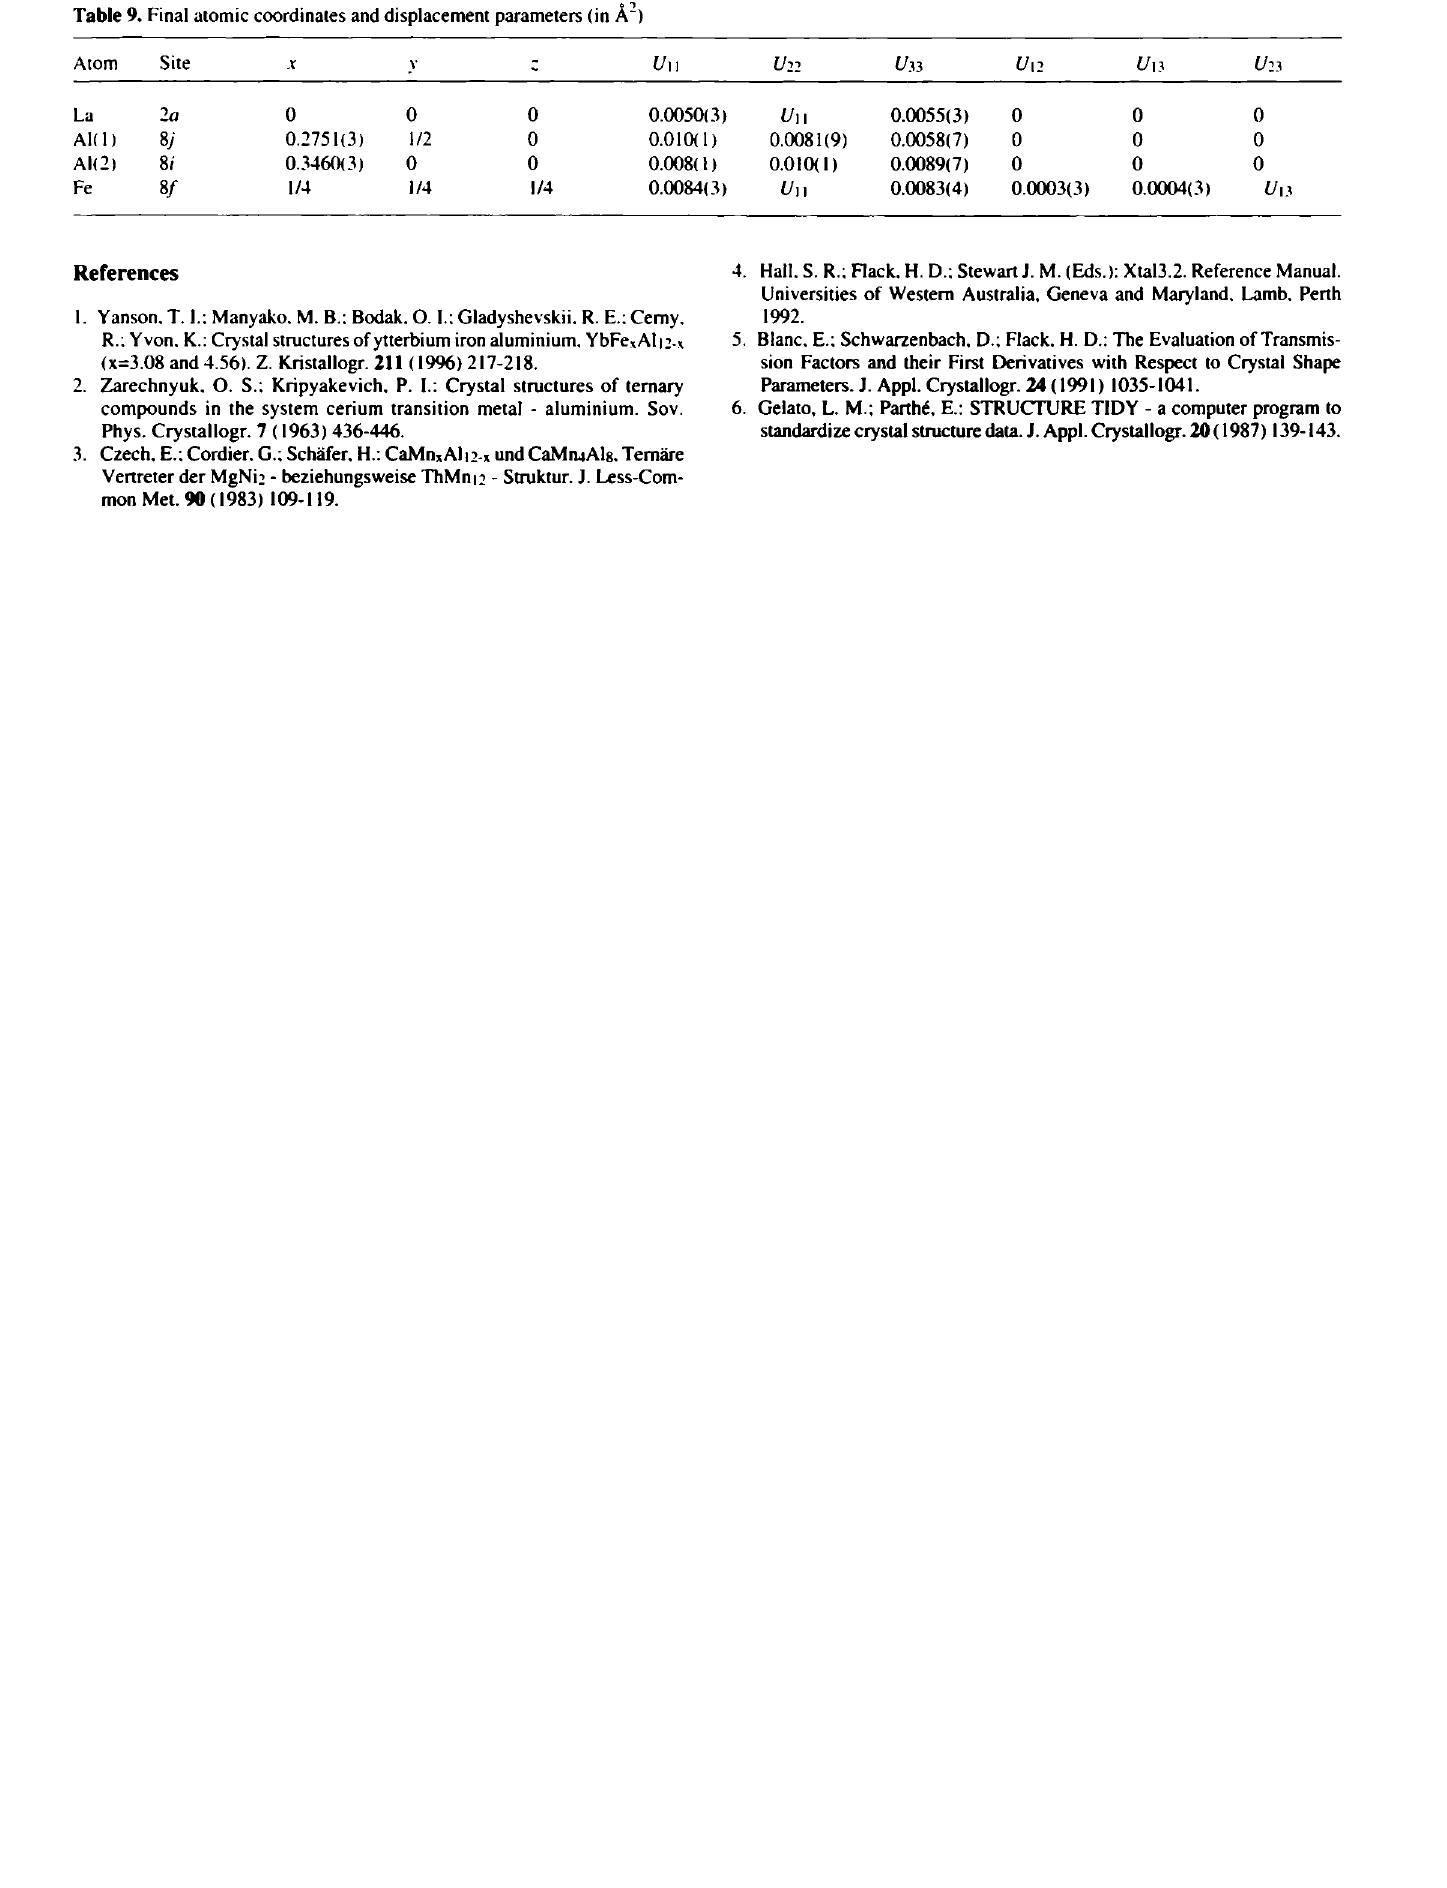
Table 9. Final utomic coordinales and displacement parameters (in À 2